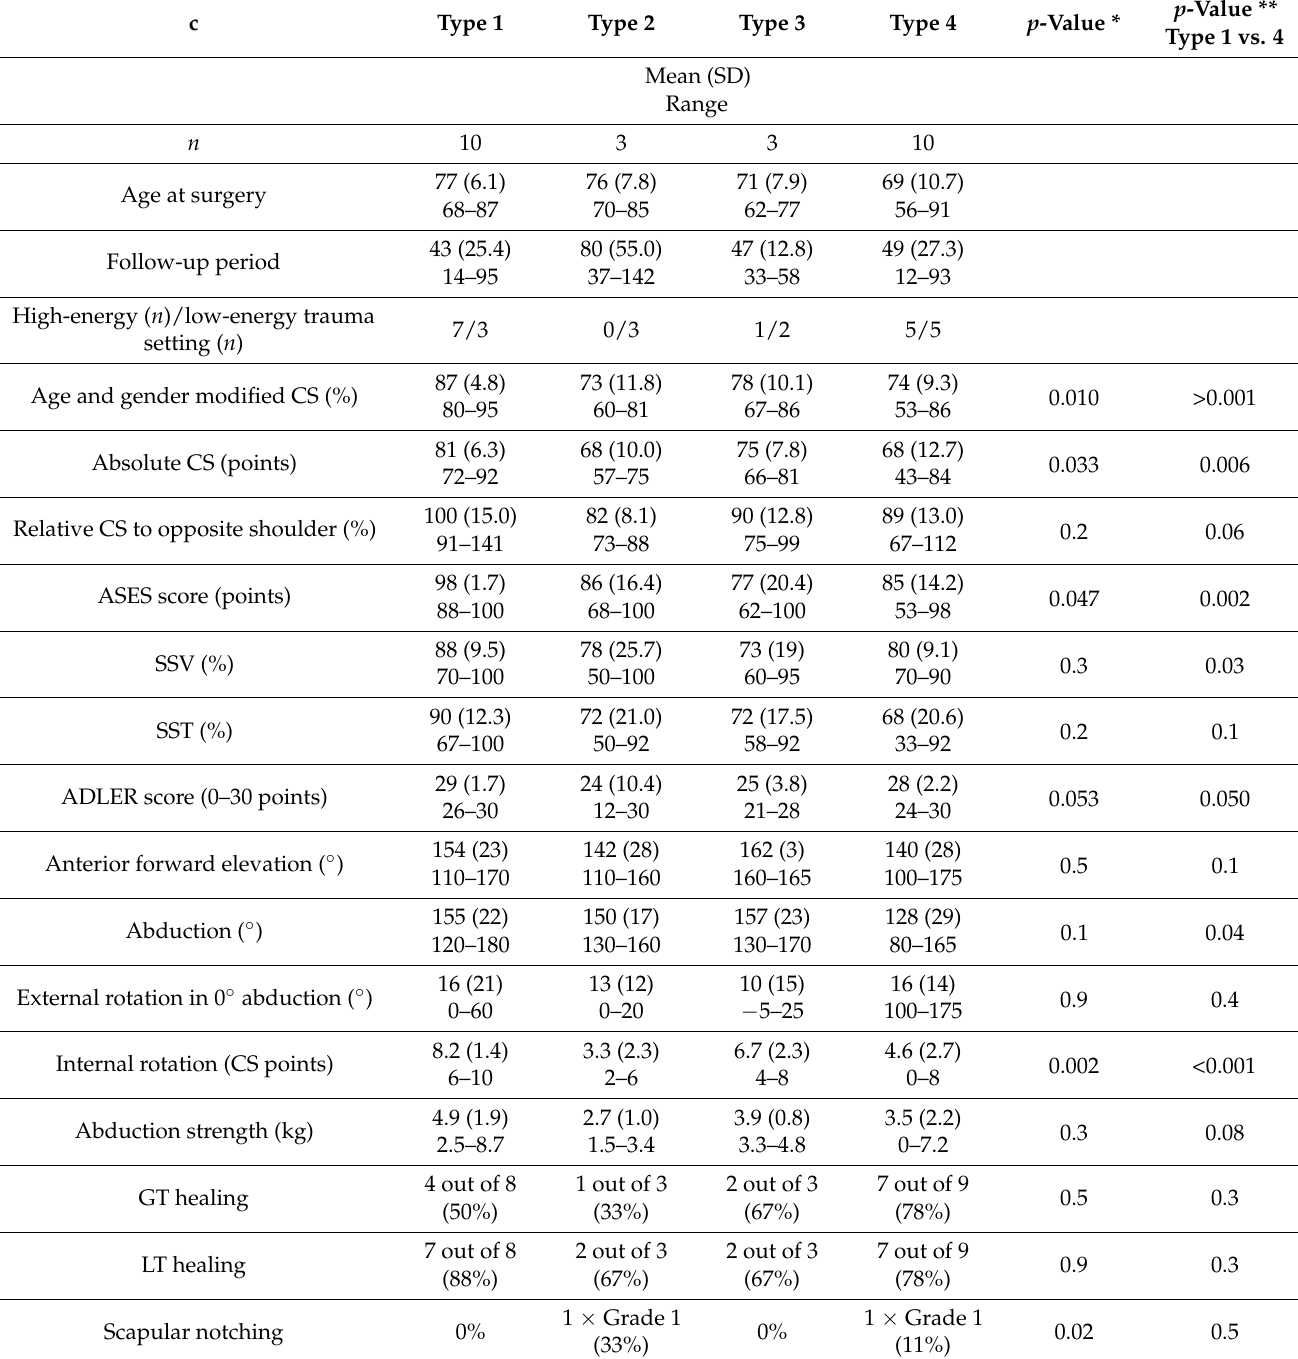
Table 3. Clinical scores with regard to head-split fracture pattern